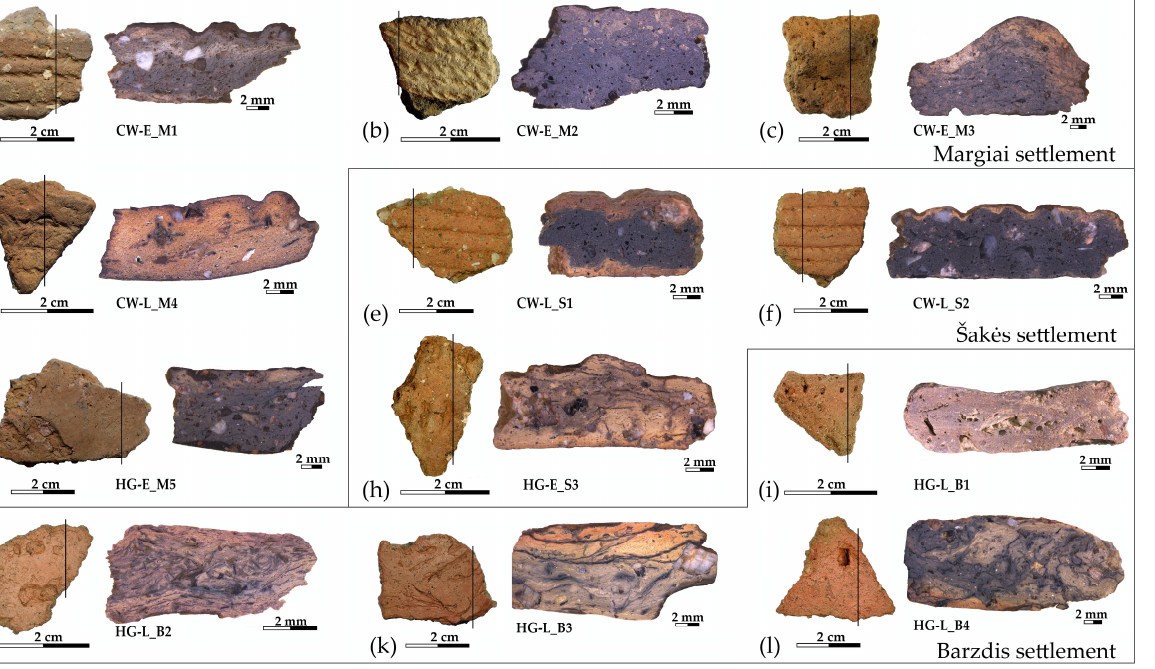
Figure 2. The pottery samples and their cross-sections: ( a – f ) cord-decorated pottery; ( g – l ) hunter-gatherer pottery.